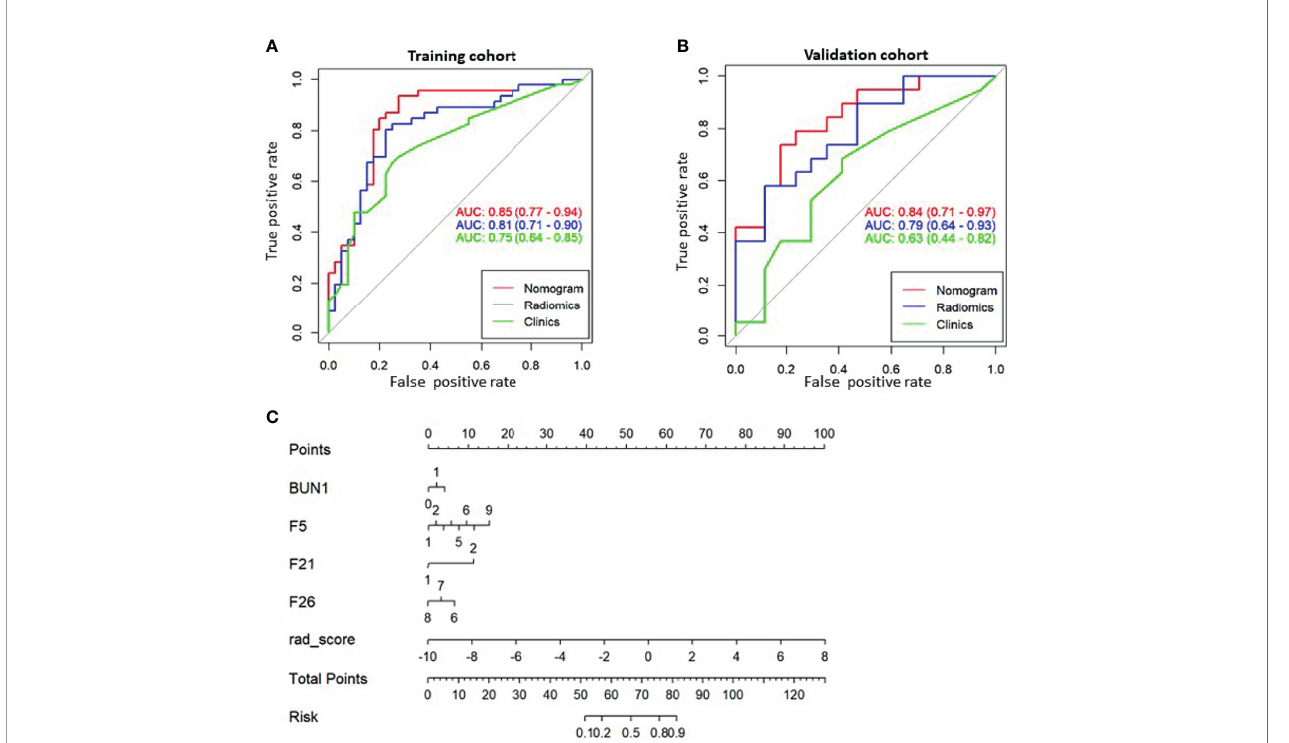
FIGURE 4 | The receiver operating characteristic (ROC) curves of the predictive models and the corresponding nomogram. ROC curve for the combined model (Nomogram, red), radiomic model (Radiomics, blue), and clinical model (Clinics, green) for (A) the training cohort and (B) the validation cohort. (C) Nomogram with signi fi cant indicators. F5, F21, and F26 are part of the Visually Accessible Rembrandt Image (VASARI) feature set. F5, enhancing tumor; F21, deep white matter invasion; F26, extent of tumor resection.